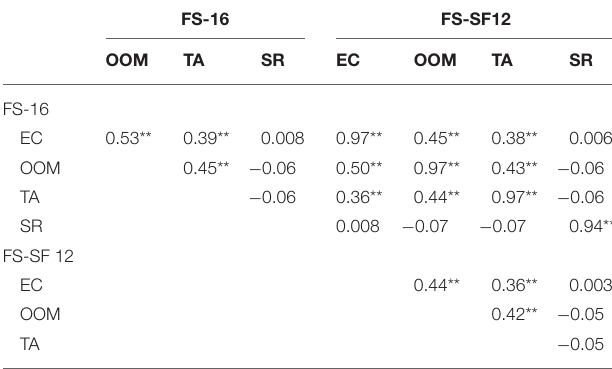
TABLE 2 | Correlation matrix of the FS-16 and FS-SF 12